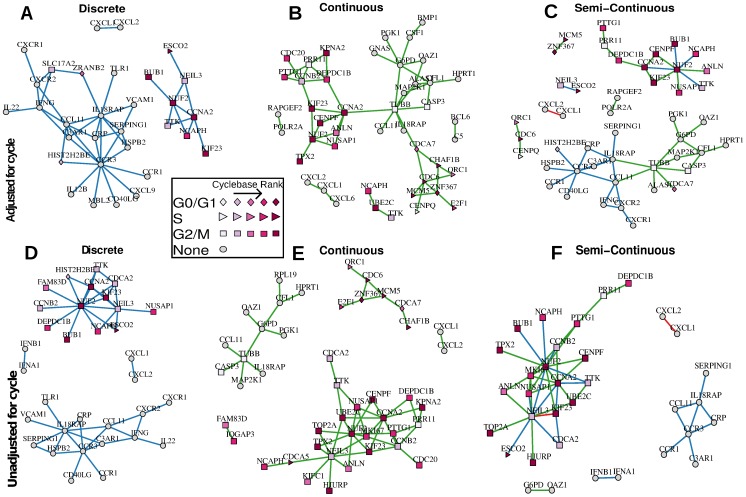
Coexpression networks estimated using the Hurdle model.Data from three cell lines and three cycles are combined and adjusted for additive effects of cell line and pre-amplification efficiency. Networks of the top 60 edges (ranked by partial correlation) using logistic regressions on discretized expression (A,D), linear regressions on positive, continuous expression values (B,E), and combining the top 30 edges from discrete and continuous components are shown (C,F). Panels A–C adjust for additive cell cycle effects, while panels D–F are unadjusted. The shape of the node corresponds to the cycle with peak expression from cyclebase, while the saturation of the node corresponds to the ranking. Blue and green edges are partial correlations detected from discrete expression and continuous expression, respectively. Red edges are detected in both discrete and continuous expression.